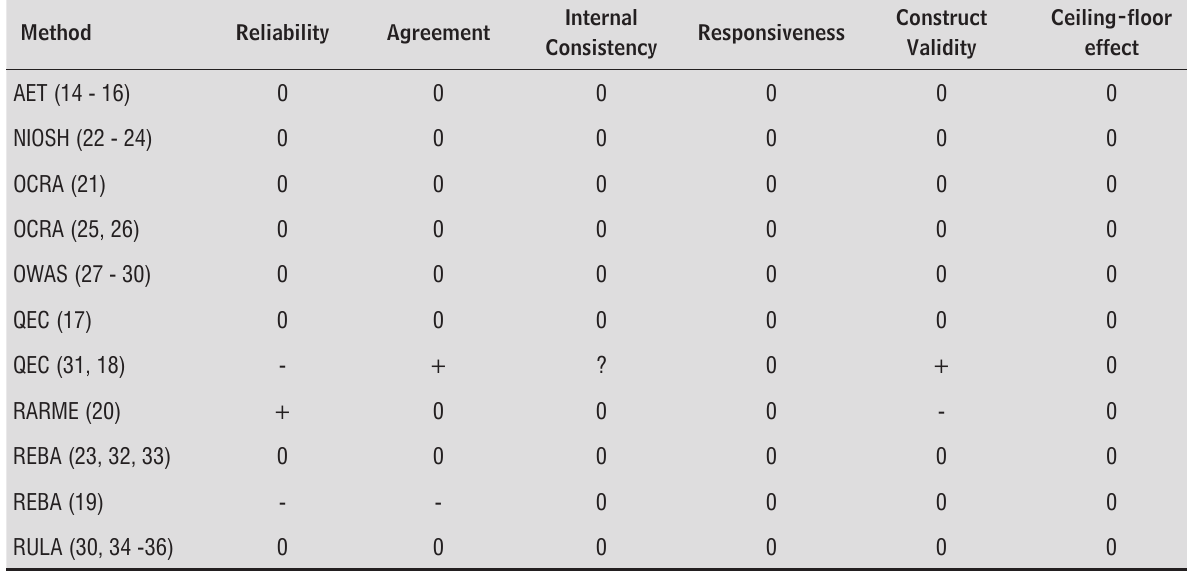
Table 4 - Tests of measuring properties of observational methods according to the Quality Criteria for Measuring Proper- ties of Questionnaires in Health